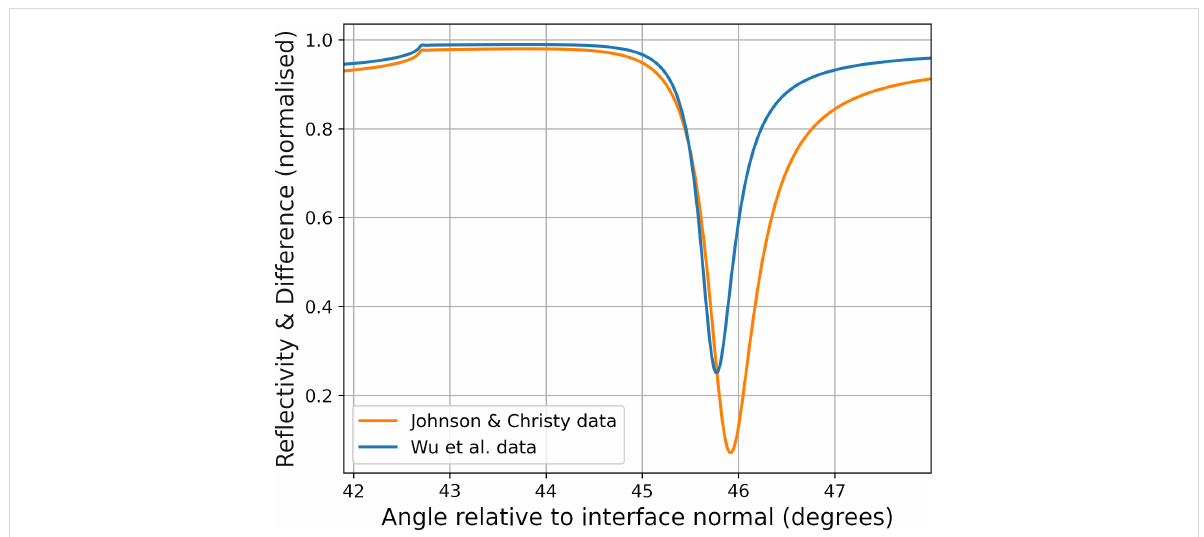
Figure 7: SPR curves resulting from electromagnetic simulations performed on a similar structure at room temperature. Different data sets were em- ployed to model the silver layer. There is a noticeable shift in the position of the minimum of the two curves.